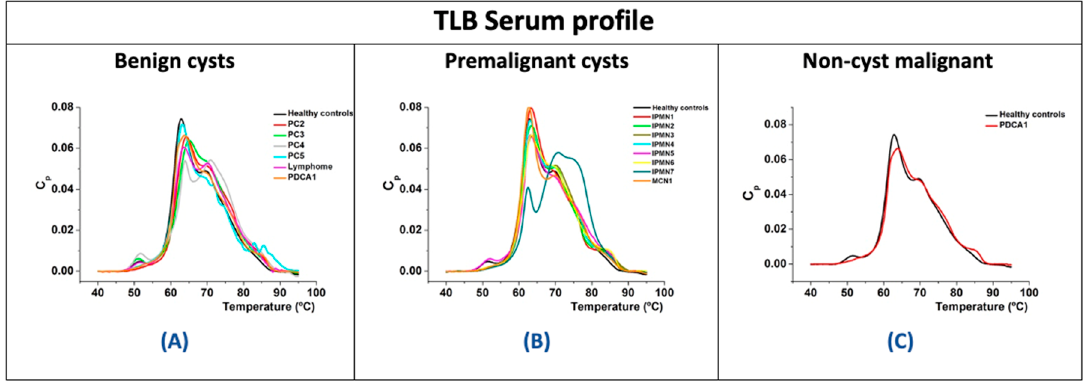
Figure 5. Examples of serum TLB thermograms from different types of cystic patients, clustered according to cyst types: premalignant ( A ), benign ( B ) and non-cyst malignant ( C ). Typical TLB thermogram for a healthy subject is represented with black line in ( A – C